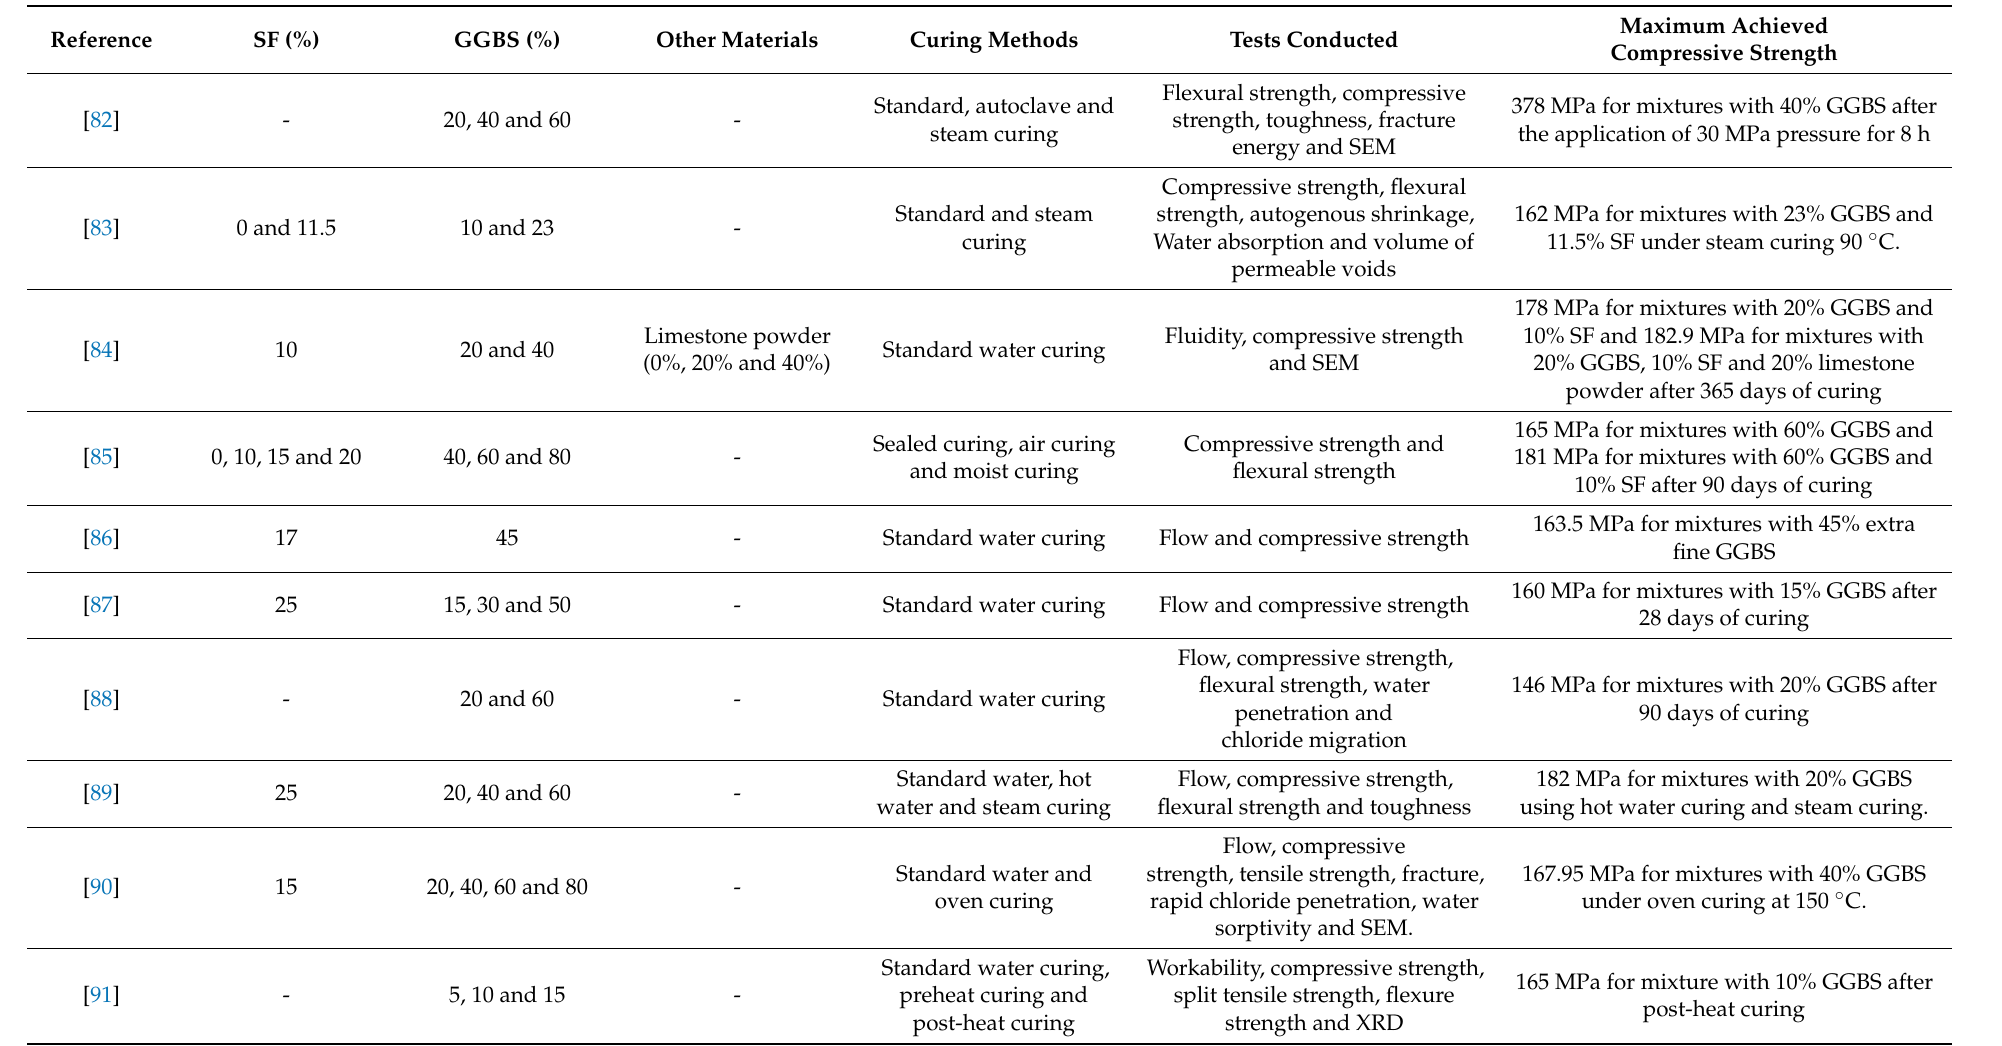
Table 2. Investigates on the utilization of GGBS in the production of